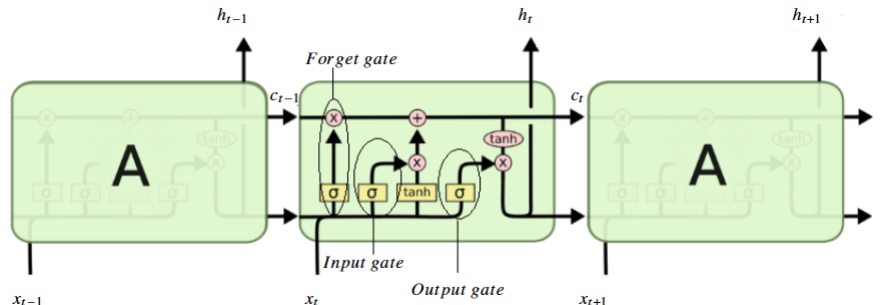
Figure 2. Contrast between a classical reccurrent neural network cell equipped with an activation function (A) and a memory block for LSTM artificial neural network